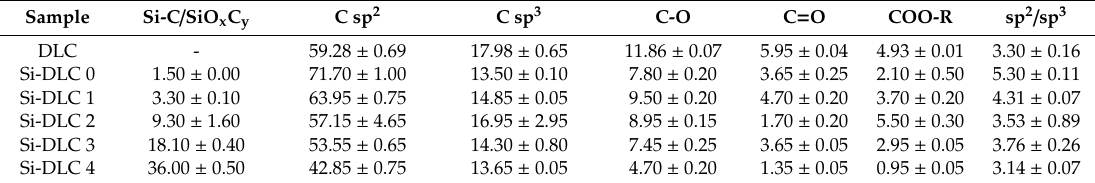
Figure 3. The deconvolution of the C 1s band for the deposited Si-DLC coatings: ( A ) Si-DLC 4, ( B ) Si-DLC 3, ( C ) Si-DLC 2, ( D ) Si-DLC 1, ( E ) Si-DLC 0. Table 2. Decomposition of the C 1s peak for the examined DLC and Si-DLC coatings.